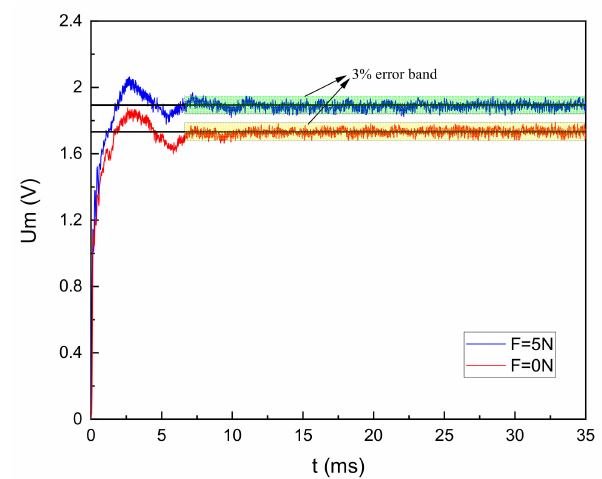
Figure 7. Stator vibration amplitude control